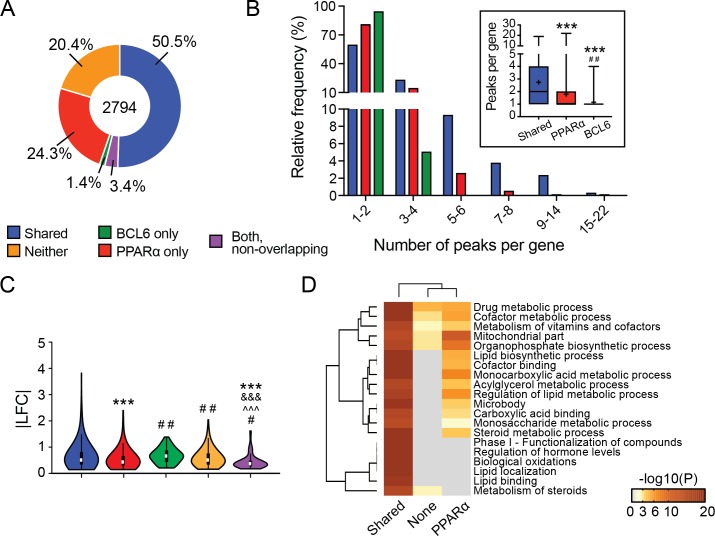
The BCL6-PPARα regulatory module clusters along dynamic fasting genes.(A) Distribution of fasting genes annotated with BCL6 and/or PPARα binding peaks. Differential fasting genes here include all significantly different genes with fasting (adjusted p-value<0.05). (B) Histogram showing the frequency of shared BCL6-PPARα peaks, PPARα only peaks, and BCL6 only peaks per fasting-regulated gene. Inset shows box plots of peaks per gene, denoting interquartile range (colored box), median (horizontal black line), mean (black ‘+’), and min to max (whiskers). (C) Absolute value of log2 fold change (|LFC|) in expression of genes differentially expressed with fasting (adjusted p-value<0.05) with a nearby shared BCL6-PPARα peak; PPARα only peak; BCL6 only peak; non-overlapping BCL6 and PPARα peaks; or no BCL6 or PPARα peak (neither). Violin plots display median (white square), interquartile range (black rectangle), 95% confidence interval (black line), and frequency (colored density plot). For (B) and (C), the Kruskal-Wallis test and Dunn’s post-hoc testing were used to compare significant differences between groups. ∗p<0.05, ∗∗p<0.01, ∗∗∗p<0.001 compares to genes with a nearby shared BCL6-PPARα peak. Similarly, ‘#’ denotes comparison to PPARα only, ‘ and ’ denotes comparison to BCL6 only, and ‘^’ denotes comparison to neither. (D) Metascape gene enrichment and clustering analysis of genes differentially expressed with fasting that have an annotated shared BCL6-PPARα peak; PPARα only peak; or neither.